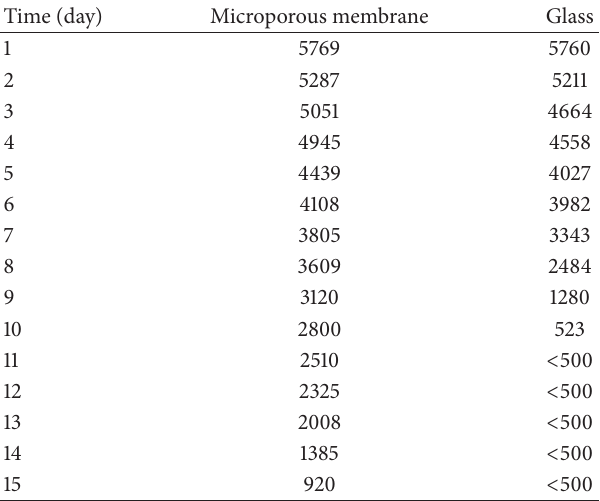
Table 1: The comparison of two substrates (microporous membrane and glass) for Raman signal at 1165cm −1